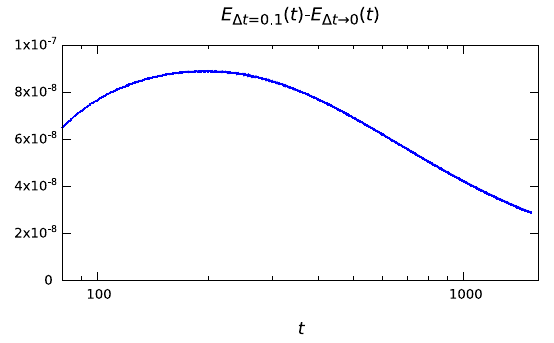
FIG. 27. Relative errors in the integration of the dynamical equations for the ( 3 þ 4 ) spin, which show a maximum at a finite time. Here, we plot the relative error in E ð t Þ during the integration with T ¼ T . We notice that the maximum relative error is MCT much smaller, by several orders of magnitude, than the physical effect we seek (energy going under the